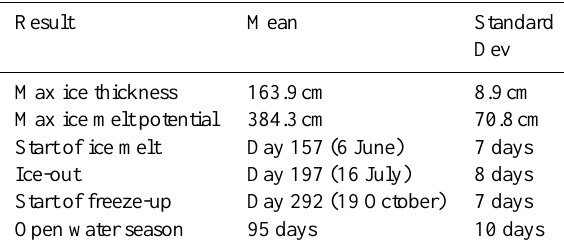
Table 3. Models results for modern era